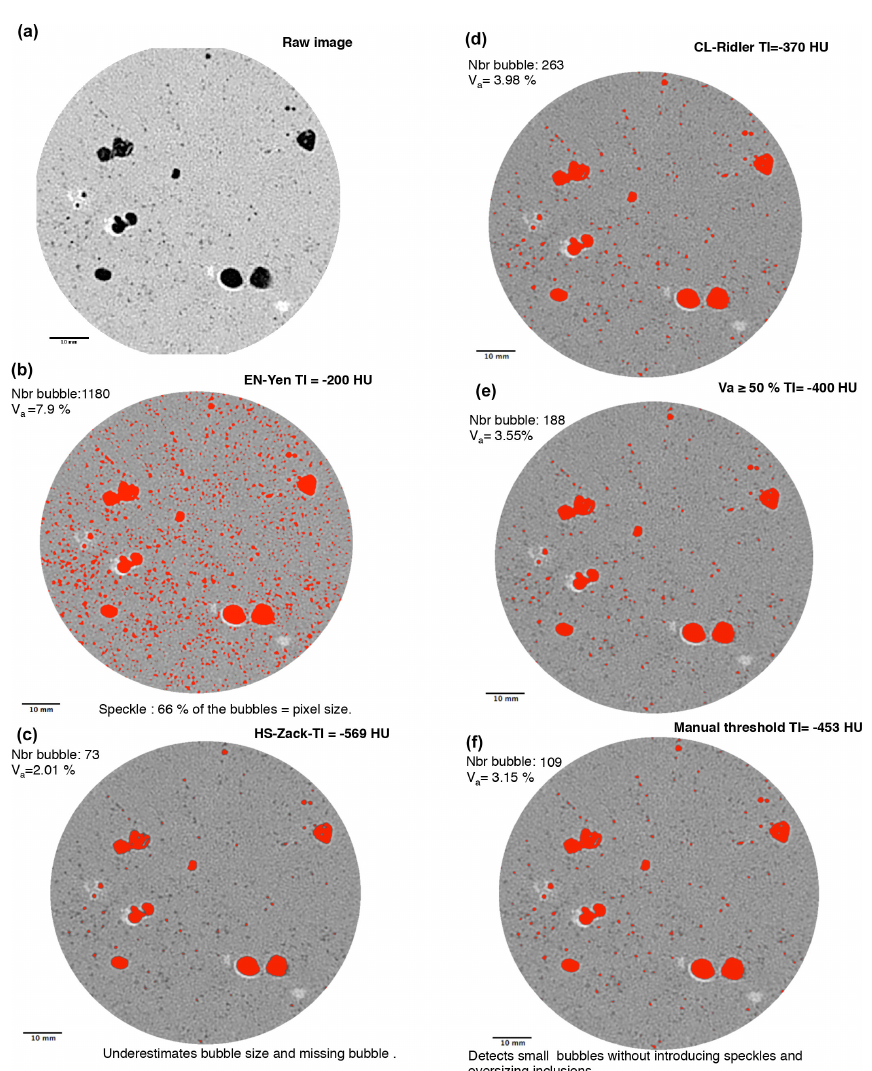
Figure 2. (a) Raw transversal slice where grey pixels represent ice, black pixels represent air, and darker grey pixels are pixel-containing air. (b) and (c) transversal slices showing the air selected pixels in red using a HU value of − 200 and of − 569 as threshold selected by the EN-Yen (b) and the HS-Zack algorithm (c) , respectively. (d) , (e) and (f) transversal slices showing the air selected pixels in red using a HU-value of − 370, of − 400 and of − 453 as threshold selected by (d) CL-Ridler algorithm, (e) by pixels containing a minimum of 50% of air and (f) by manual